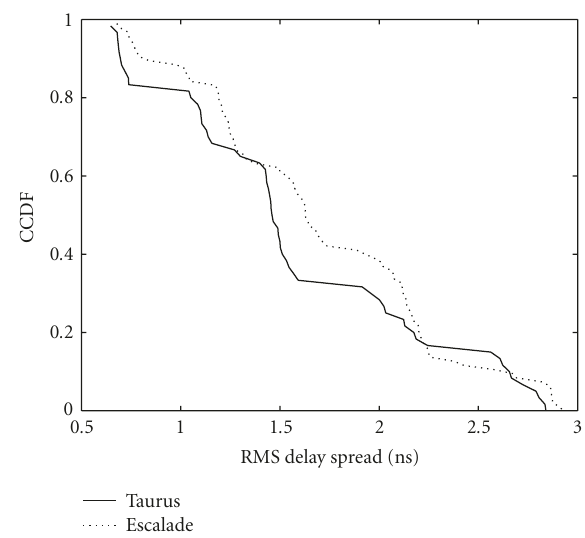
Figure 10: CCDF of the RMS delay spread for UWB propagation inside the engine